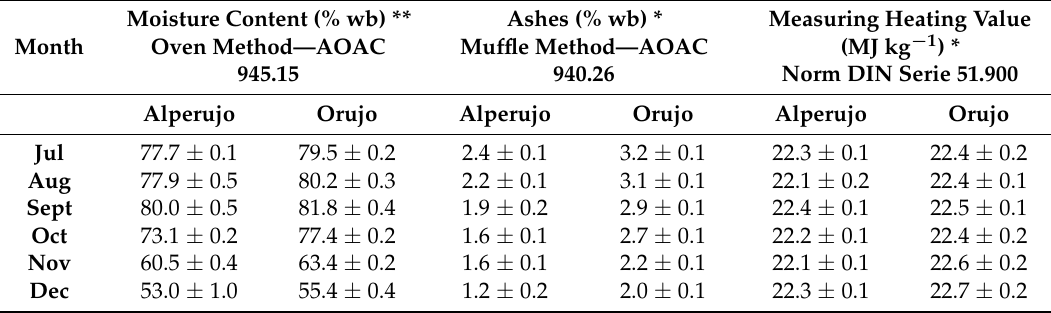
Table 1. Results of the physical-chemical analysis for samples of alperujo and orujo corresponding to the initial conditions before processing in the drying trommel over time. Deviations correspond to the standard deviation of